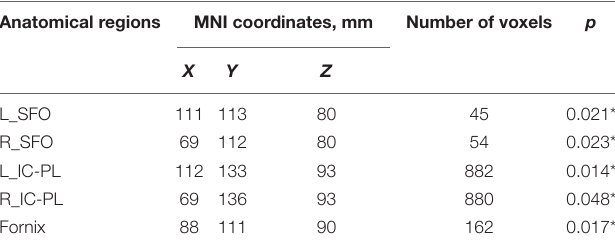
No region in post-treatment MDD showed a higher FA value than that in the HC ( Figure 2